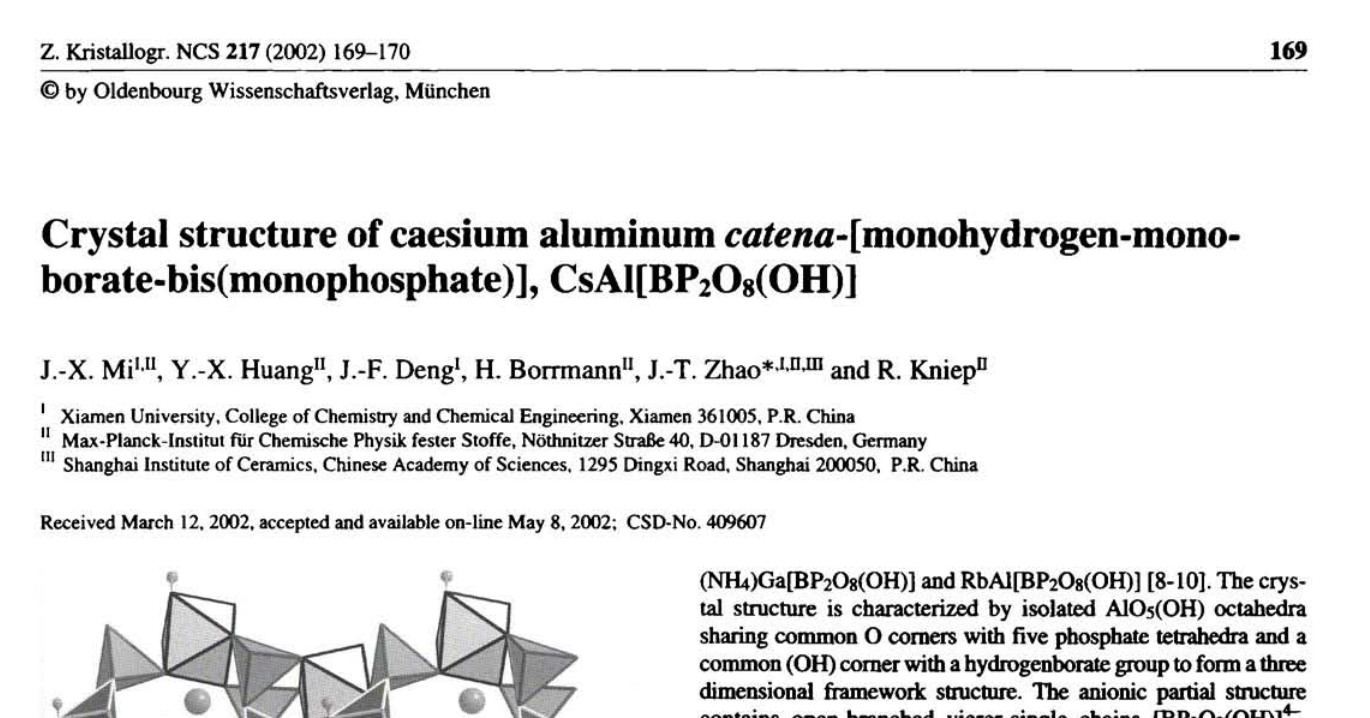
Table 1. Data collection and handling.